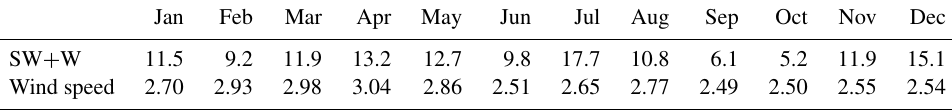
Table 2. Monthly mean wind speeds (ms − 1 ) and occurrence frequencies (%) of the southwest (SW) and west (W) winds at the Dongtan (DT) site, a remote rural site near Sheshan Island (SSI), from 2012 to 2017.